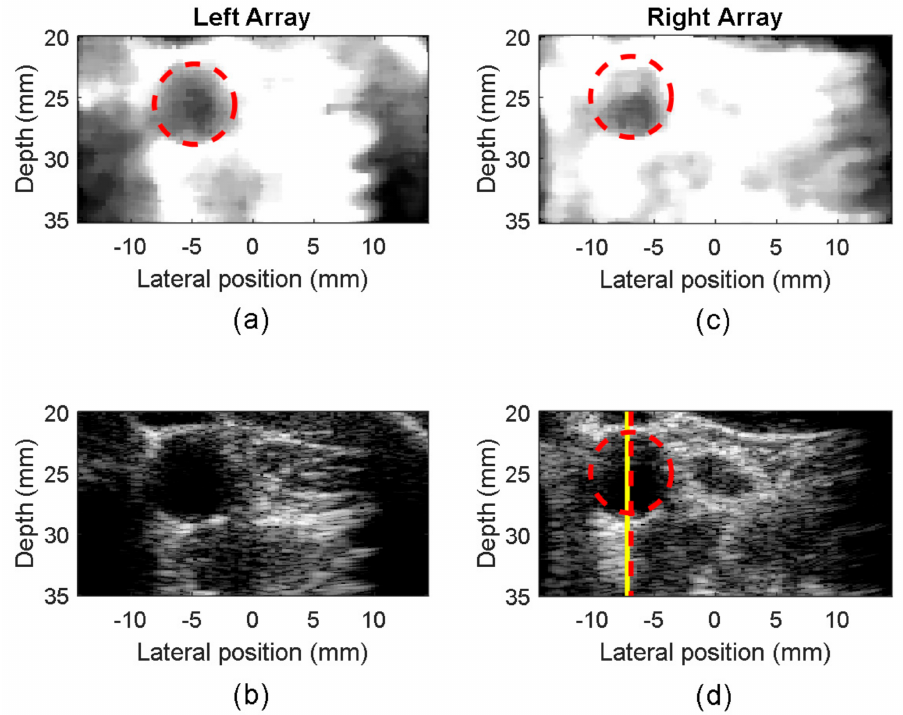
Figure 5. Pre-processed ( a , c ) and raw B-Mode ( b , d ) images acquired from the left ( a , b ) and right ( c , d ) arrays on a volunteer. The automatic carotid segmentation (red dashed circles), the automatic Doppler lines (vertical red dashed lines) and the reference Doppler lines (yellow vertical lines) are superimposed on the